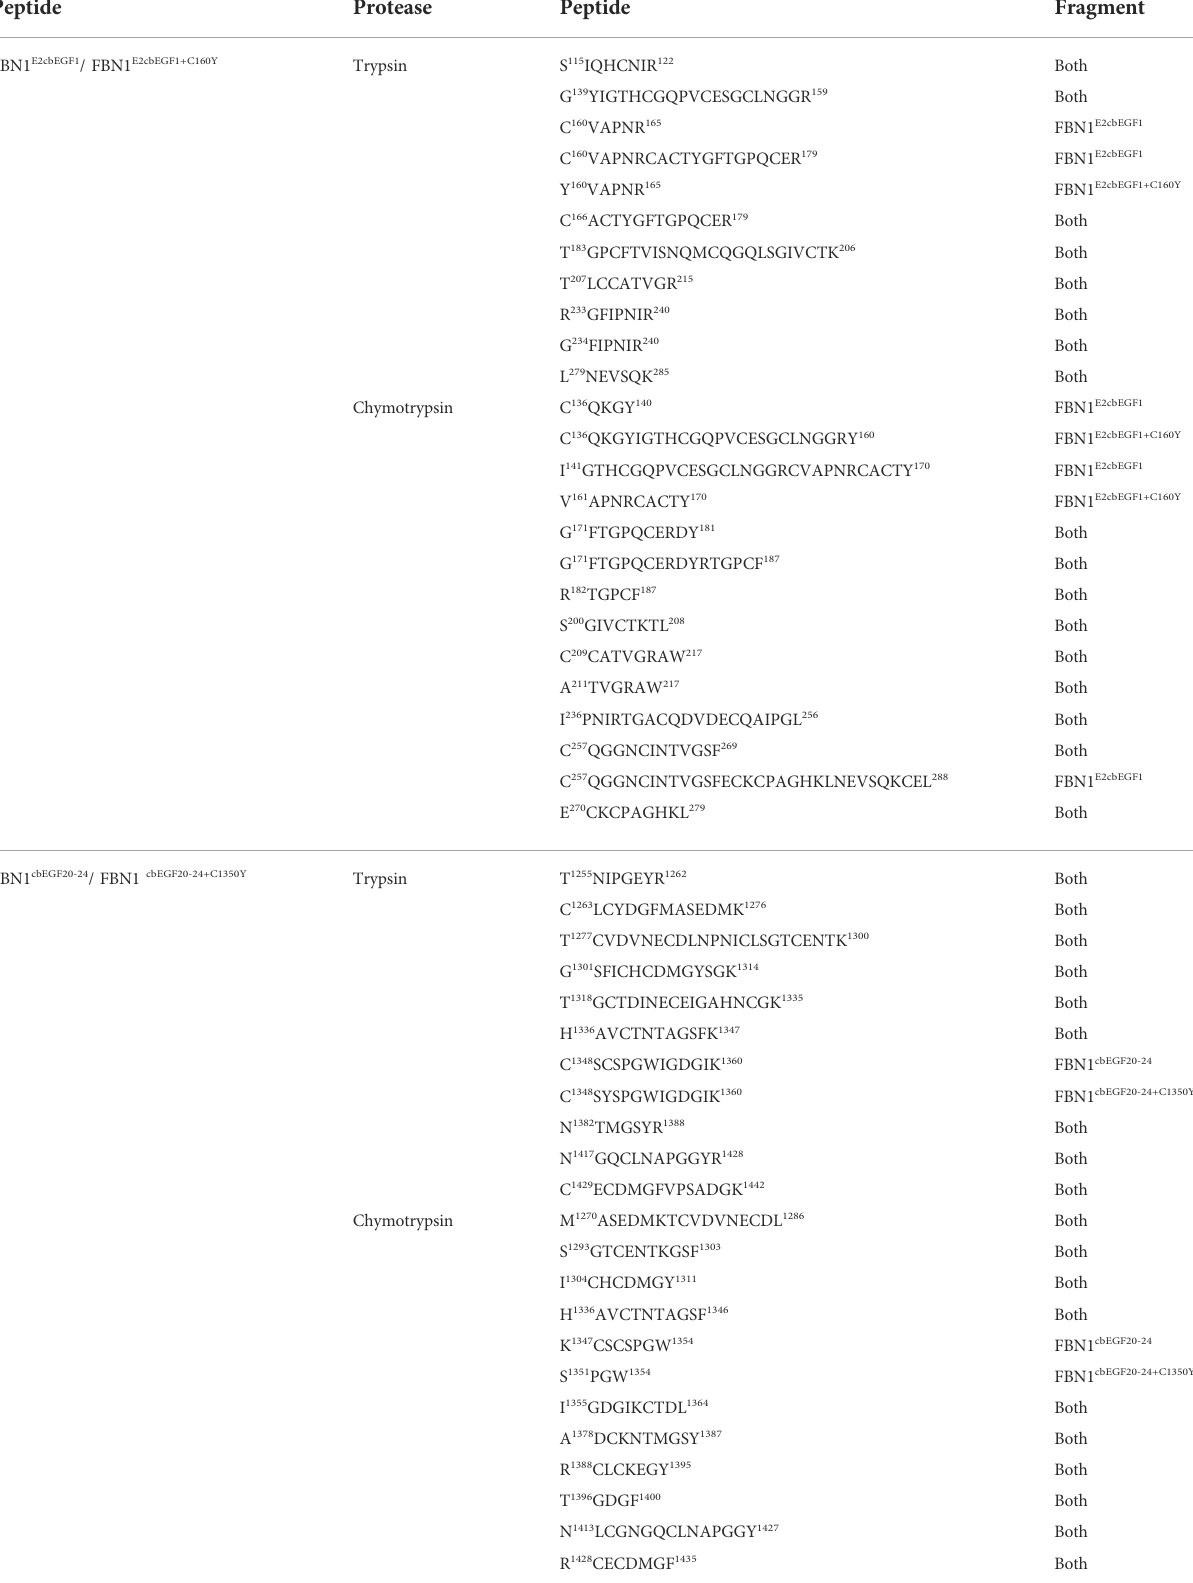
Peptide Protease Peptide